Question: Write the caption for this figure.
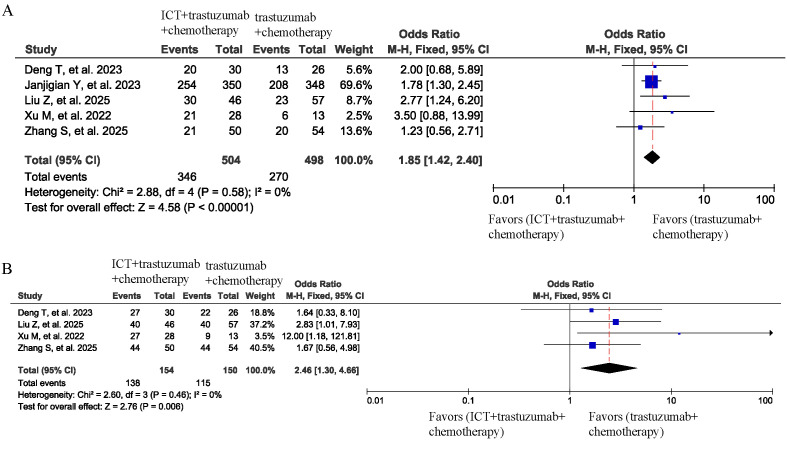
Answer: Forest plots of odds ratios (HR) with 95% confidence intervals (CI) for (A) Objective Response Rate and (B) Disease Control Rate in patients with HER2-positive gastric or gastro-oesophageal adenocarcinoma.